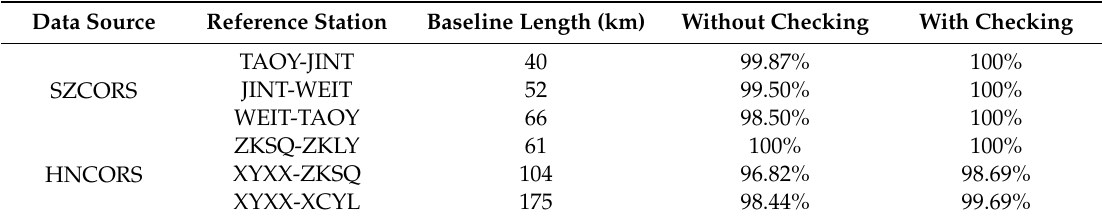
Table 2. AR success rate with and without reliability validation for the different baselines. Data